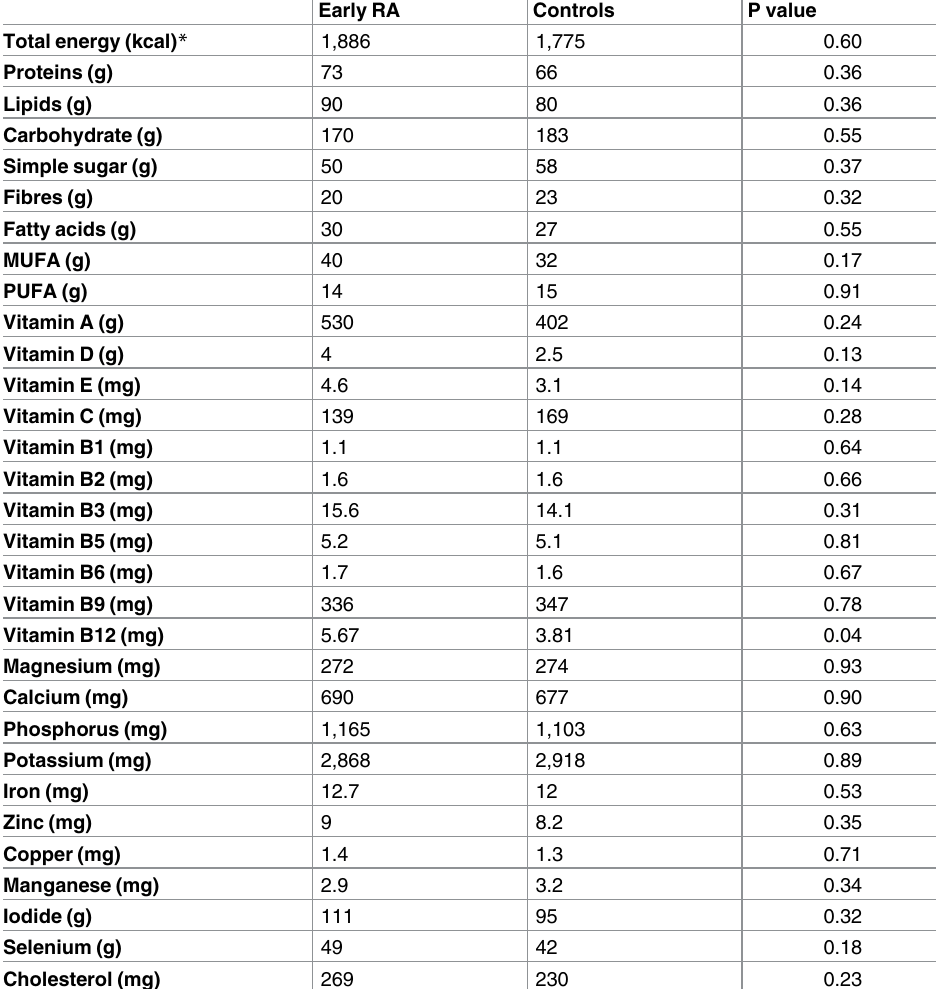
Table 3. Daily nutrient intake in patients with early RA and matched